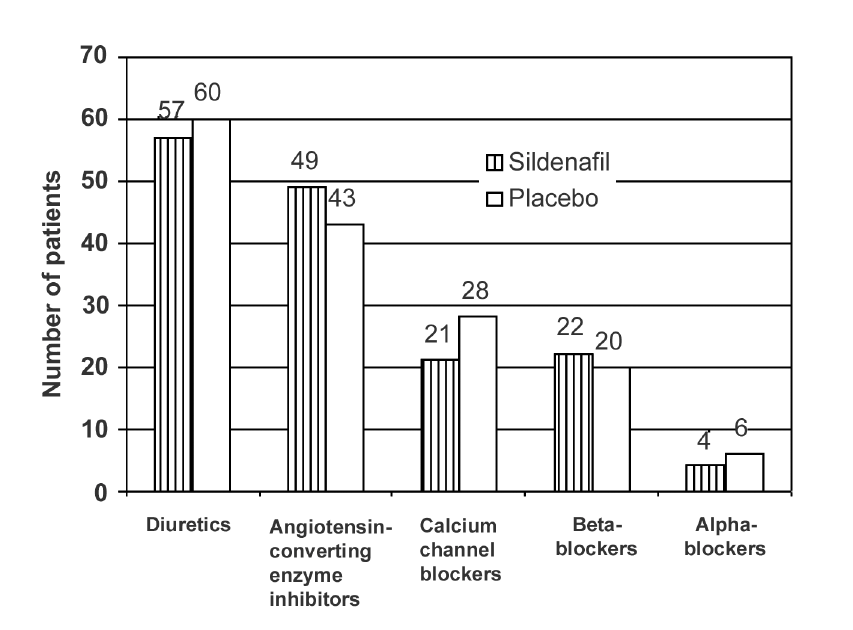
Figure 1 – Anti-hypertensive drugs in both